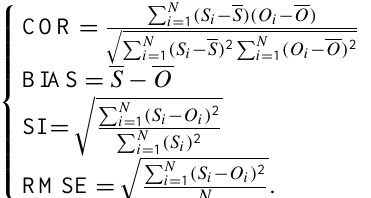
sented in Table 3. Grid TET is a stretched curvilinear hor- izontal grid with a variable horizontal resolution ( Madec, 2008), from 8 m × 8 m at the nearest grid point from the T ˆ et mouth to 180 m × 180 m at the external border. Bathyme- tries from Bern ´ e et al. (2002) and from the LiDAR for the nearshore are used. The last one has a resolution of 5 m that